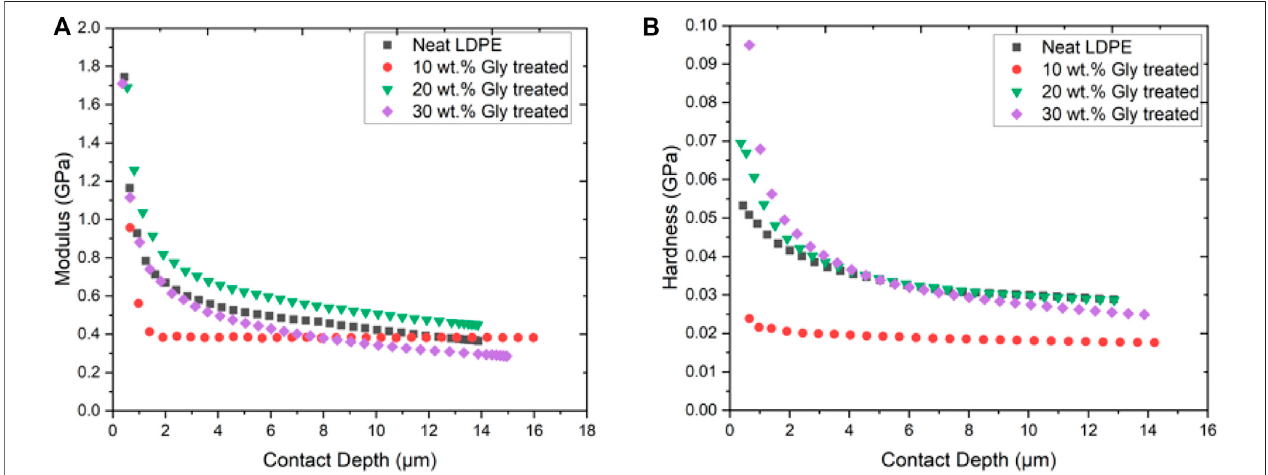
FIGURE7| Modulusandhardnessasafunctionofcontactdepth: (A) moduluscurvesofglycerol-treatedRHreinforcedbiocompositeswithloadingsof10,20,and 30 wt%; (B) hardness curves of glycerol-treated RH reinforced biocomposites with loadings of 10, 20, and 30 wt%.